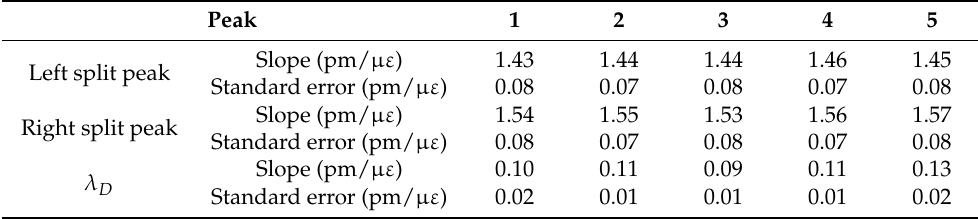
Table 3. Linear fit of peaks 1–5 of FBG 3, including left and right split peaks and their difference in the second regime as a function of strain from 0% to